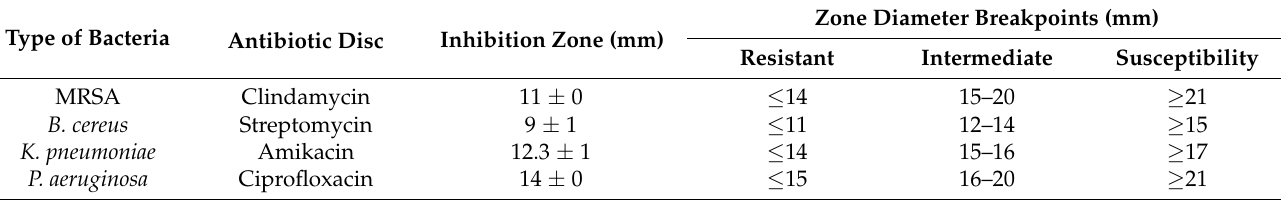
Table 5. Measurements of inhibition zones of Ag–Si thin films in contact with bacteria. Type of